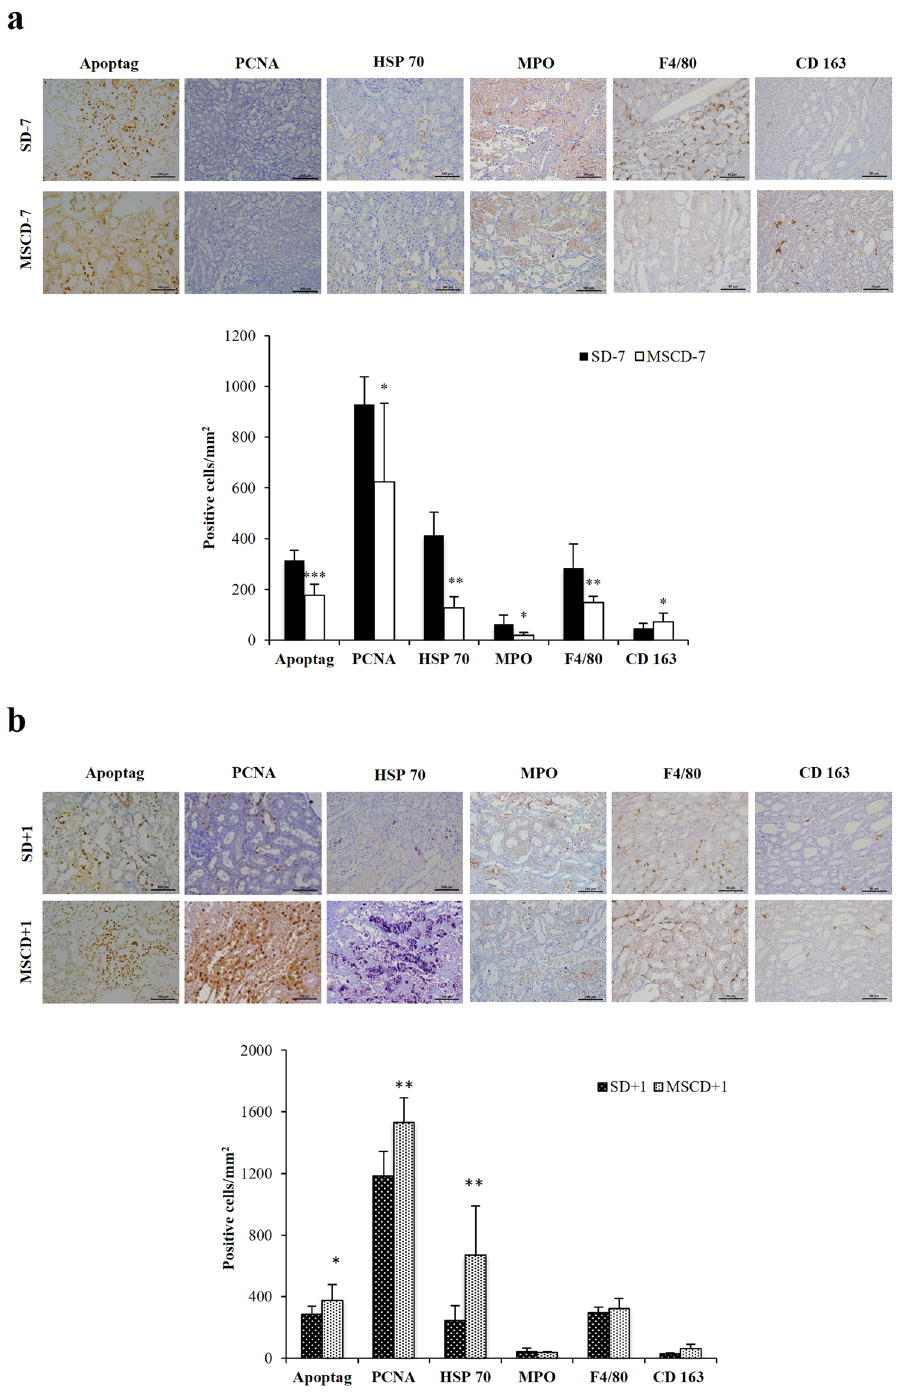
Figure 2. Quantification of markers of apoptosis, cell proliferation, inflammation in renal parenchyma after ischemia/reperfusion according to the timing administration of MSC. Immunohistochemistry and quantifications for Apoptag, proliferative cell nuclear antigen (PCNA), Heat-Shock Protein 70 (HSP70), myeloperoxidase (MPO), F4/80 and CD163 in SD − 7 and MSCD − 7 ischemic kidneys ( a ) and in SD + 1 and MSCD + 1 ischemic kidneys ( b ). One-way analysis of variance was performed among groups. Significant differences are indicated, * p ≤ 0.05, ** p ≤ 0.01 and *** p ≤